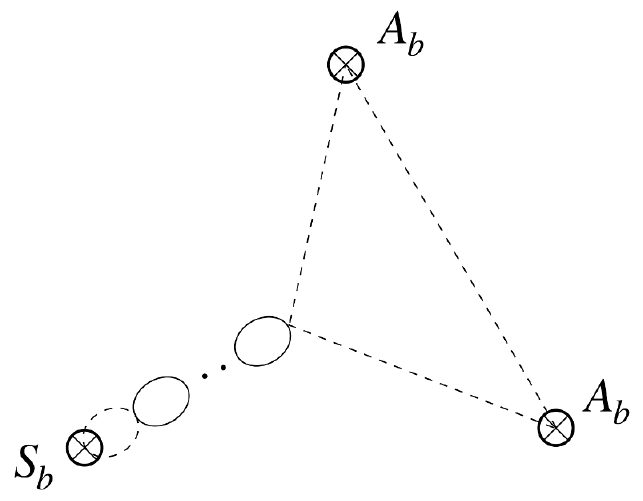
Figure 4 . The three-point function of S b with two A b ’s is that of the undeformed theory, with a sum over bubbles attached to the S b vertex of the undeformed three-point